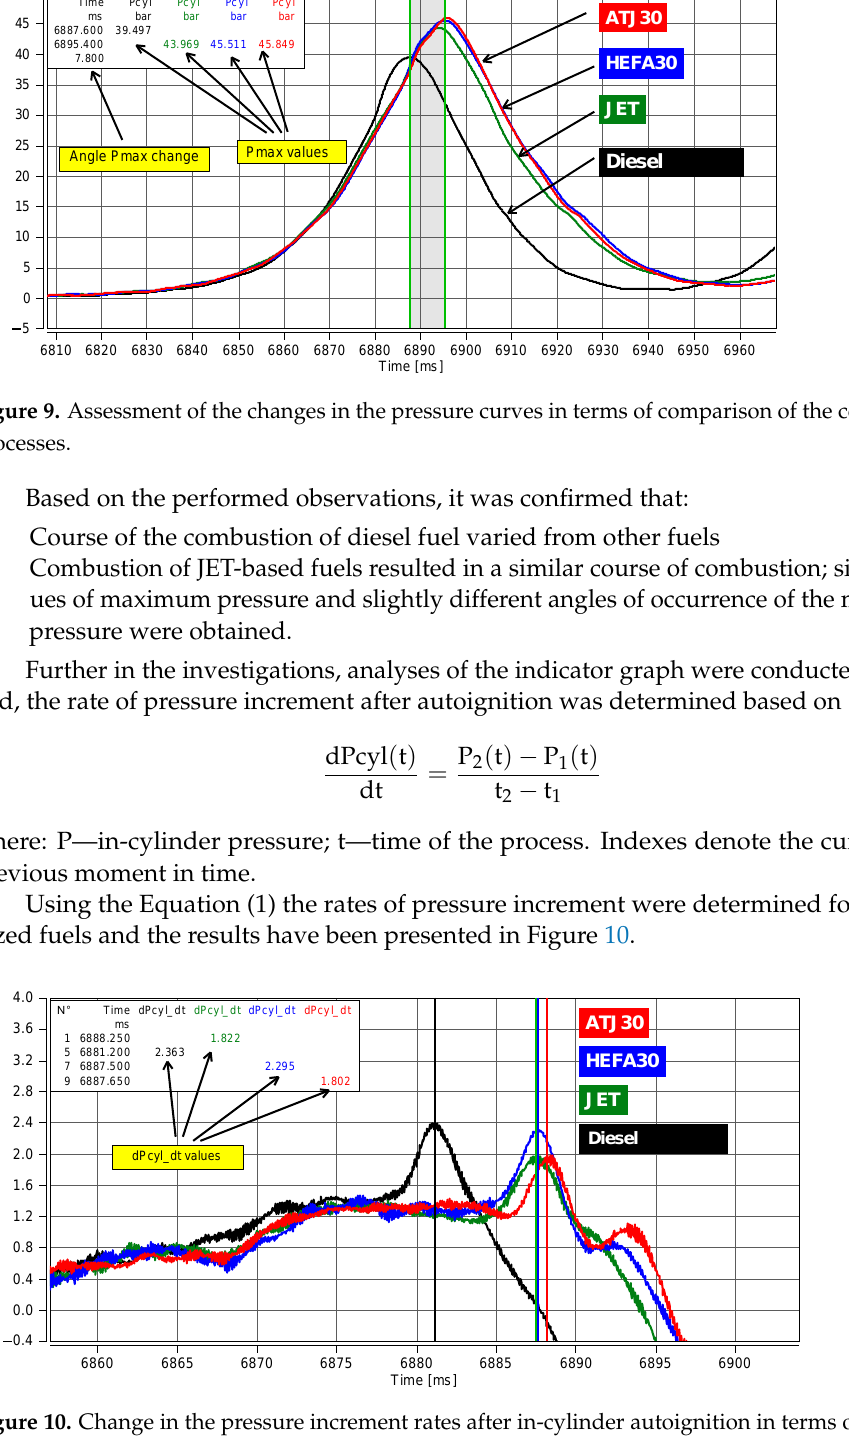
Figure 10. Change in the pressure increment rates after in-cylinder autoignition in terms of comparison of the combustion process.